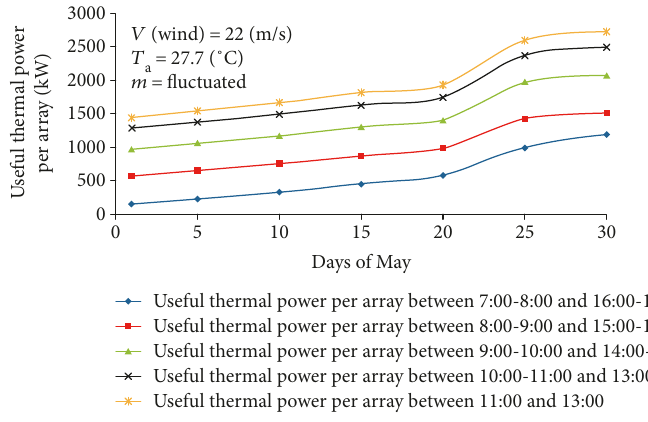
Figure 5: Useful thermal power per array for May.